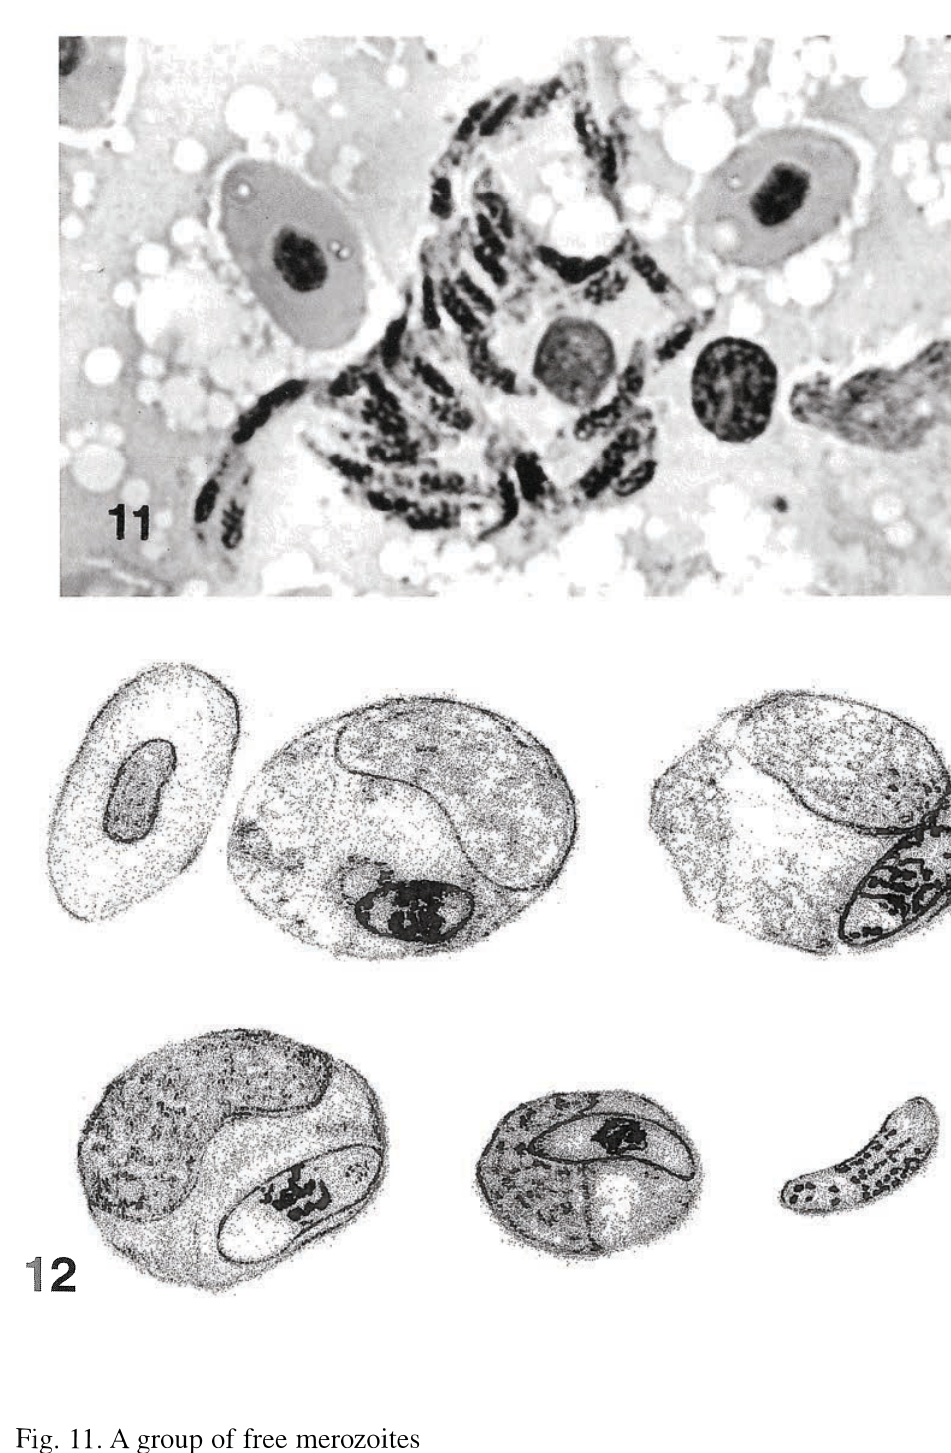
Fig. 11. A group of free rnerozoites Fig. 12. Gamonts occurring in leucocytes and